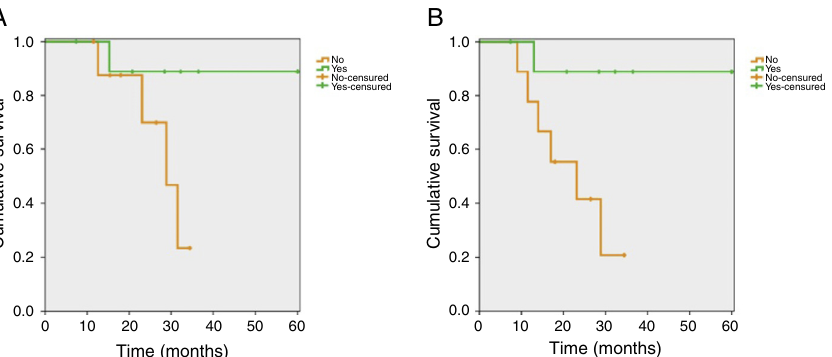
Overall survival (A) and progression-free (B) curves stratified for pathological response (88.9% vs. 23.3%; p = 0.049 --- log-rank test for overall survival and 77.8% vs. 20.8%, p = 0.017 --- log-rank test for survival free of disease